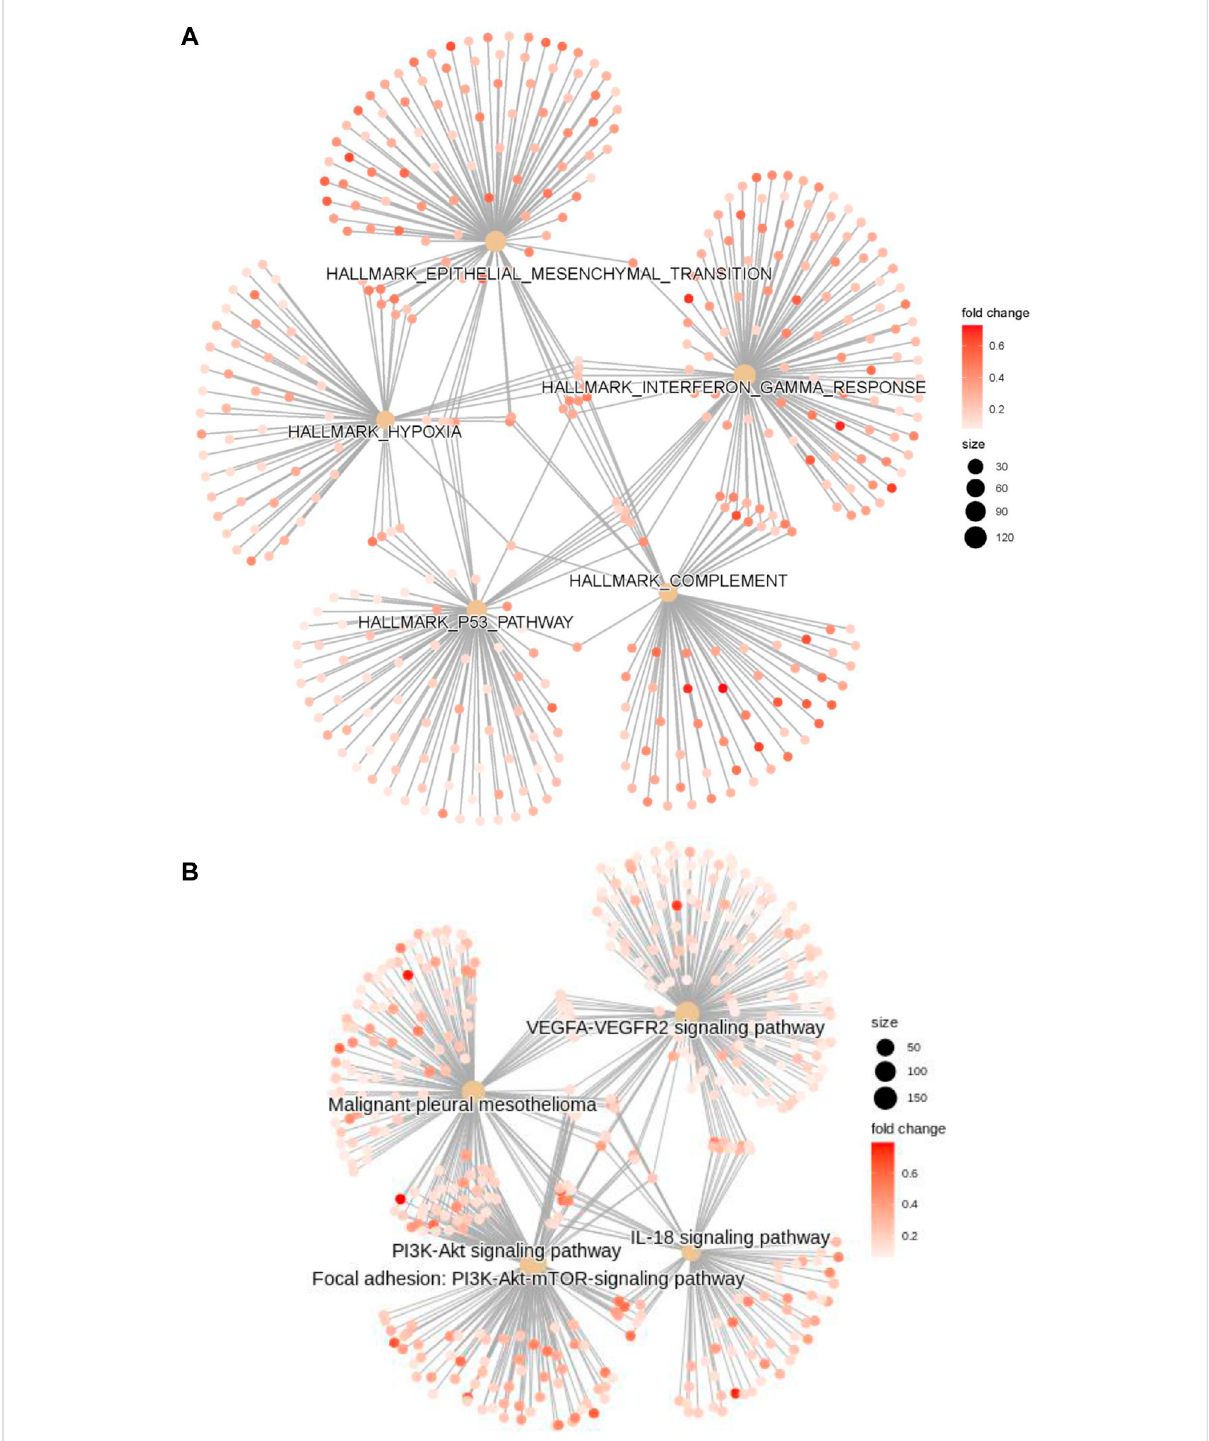
FIGURE 6 The cnetplots show the relationship between tumor hallmarks and metabolic pathways (A,B) .